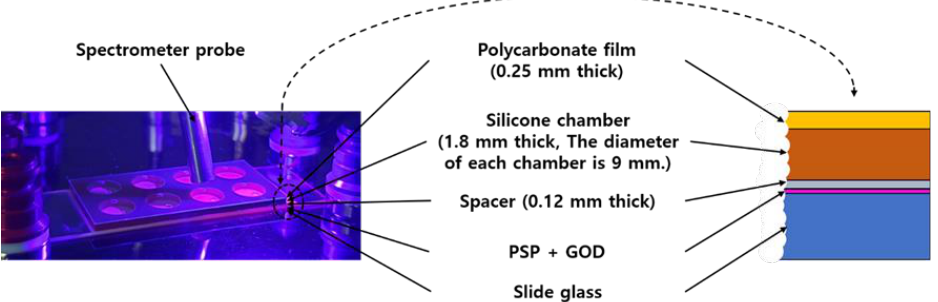
Figure 1. Photo (left) and cross-sectional view (right) of the produced glucose sensor. The photo also shows the spectrometer probe used for the